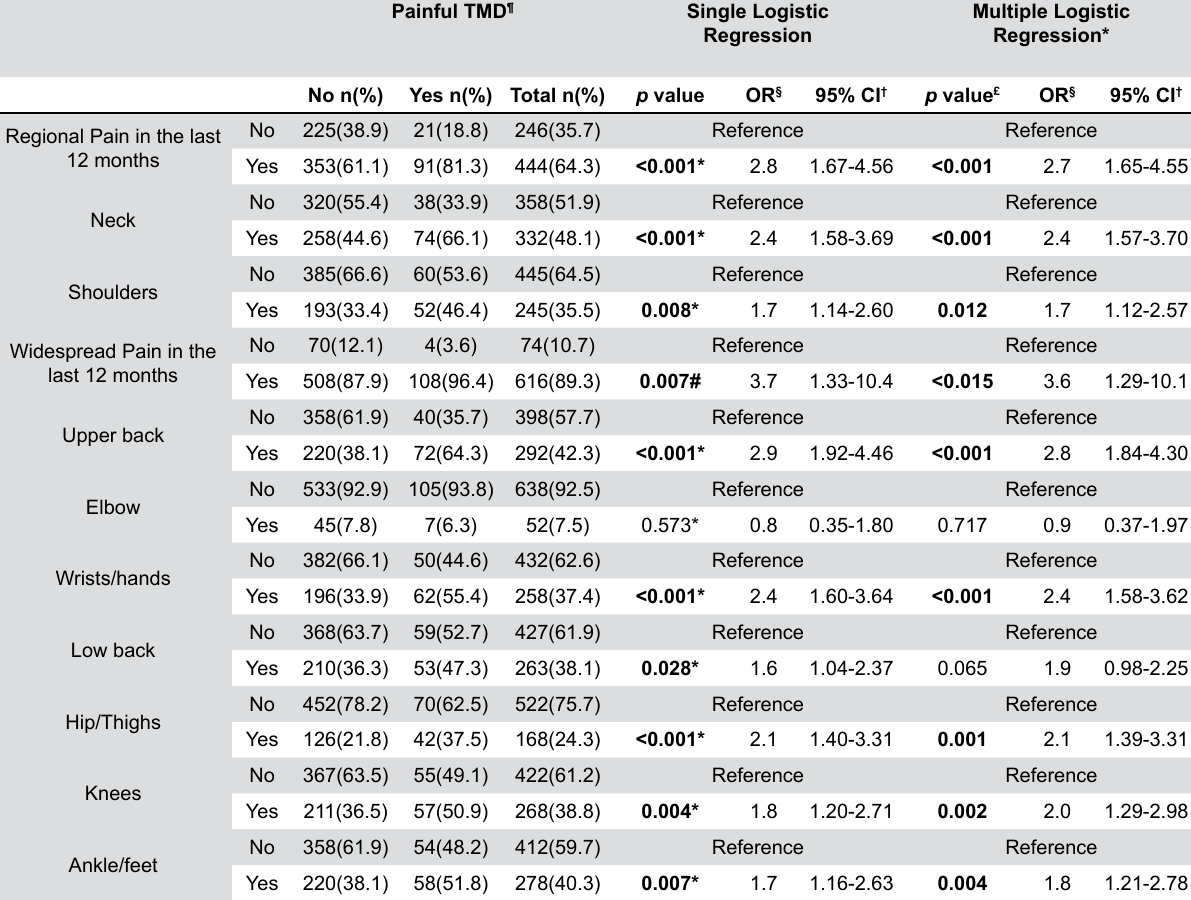
Table 3- Logistic regression model for the association between painful TMD and body pain